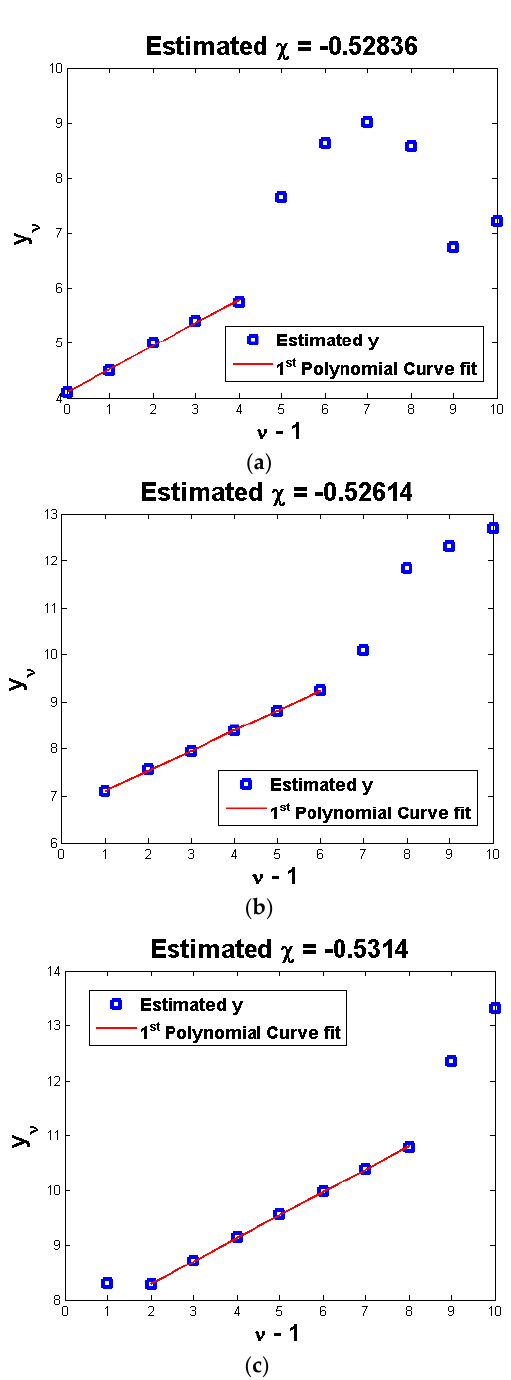
Figure 5. Estimated y in Equation (35) ( □ ), results of curve fit with 1 st polynomial equation ( —) and estimated results of χ from the curve fitting results: ( a ) for 2 nd mode, ( b ) for 4 th mode, ( c ) for 6 th mode.